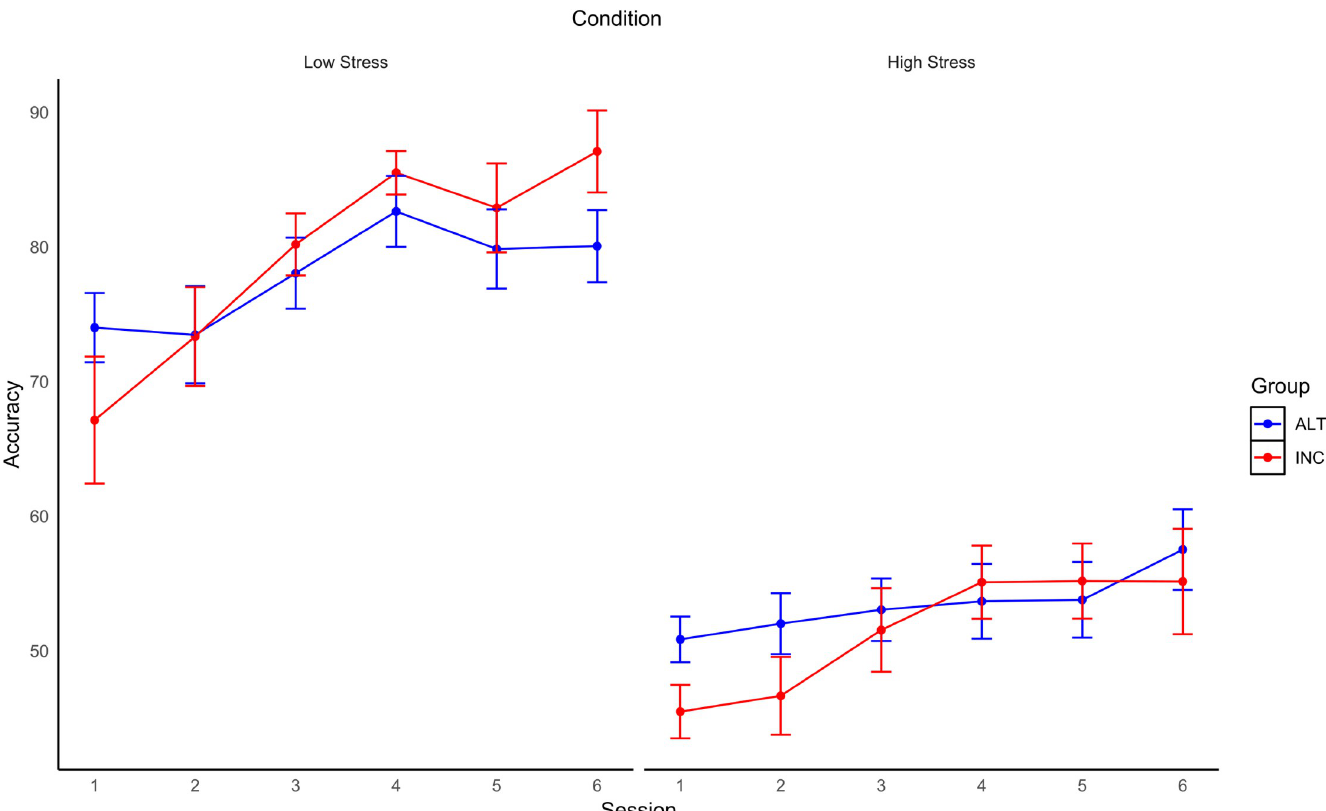
Fig 9. Changes in shooting accuracy across sessions in low and high time-stress conditions for each group. Percentage enemy targets hit over Sessions in the Low (left) and High (right) time-stress conditions for each Group (error bars are SE).